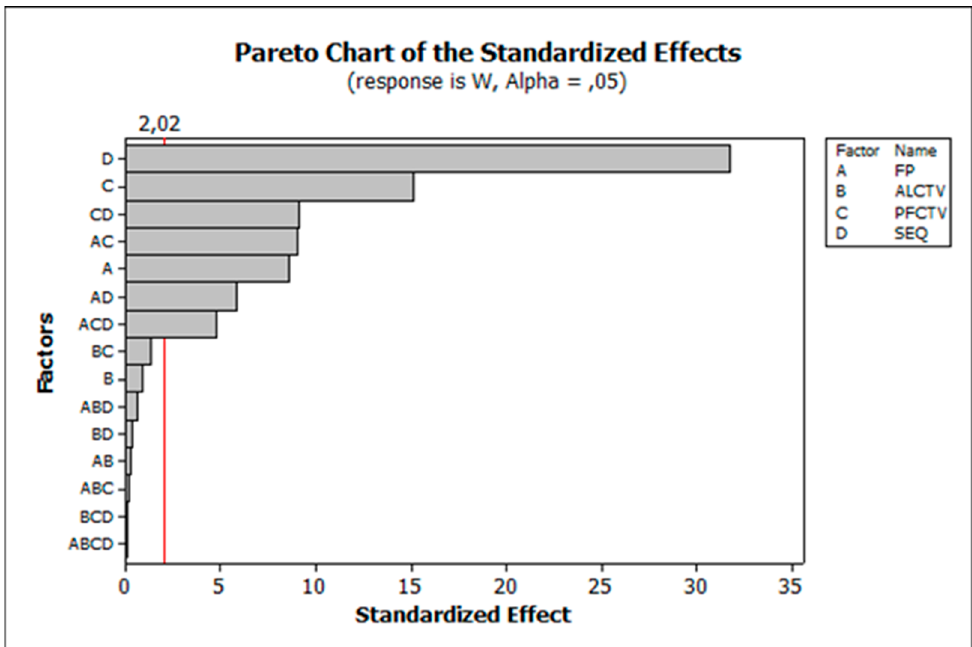
Figure 4. Pareto chart of the standardized effects of the inputs on W